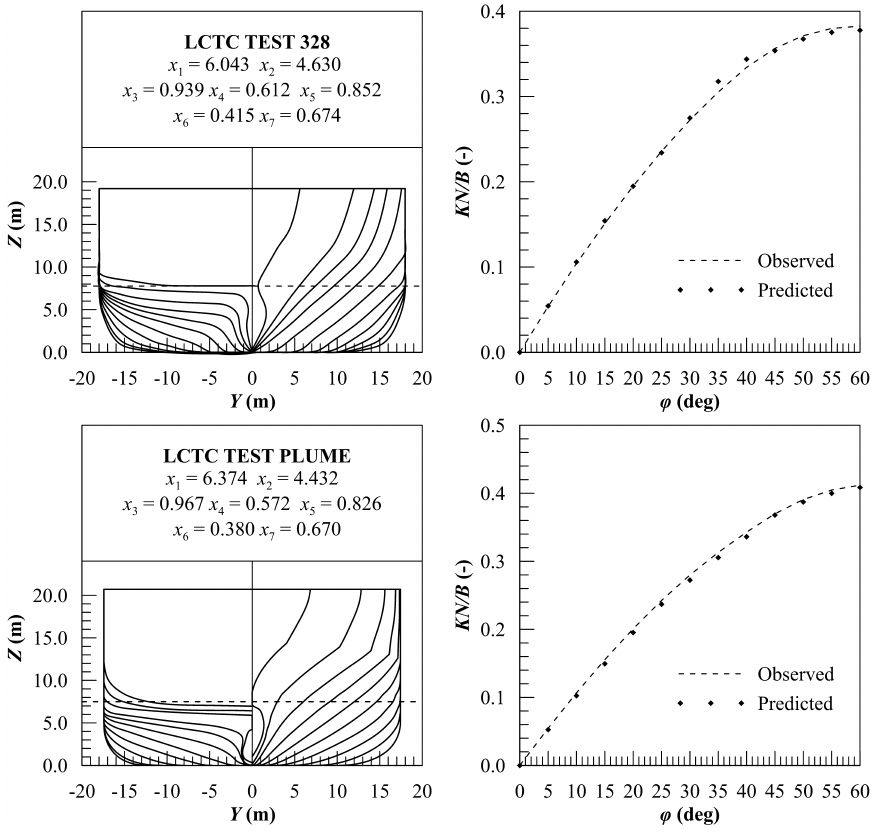
Figure 8. Test body plans, main particulars and comparison of the predicted and observed non- dimensional cross curve of